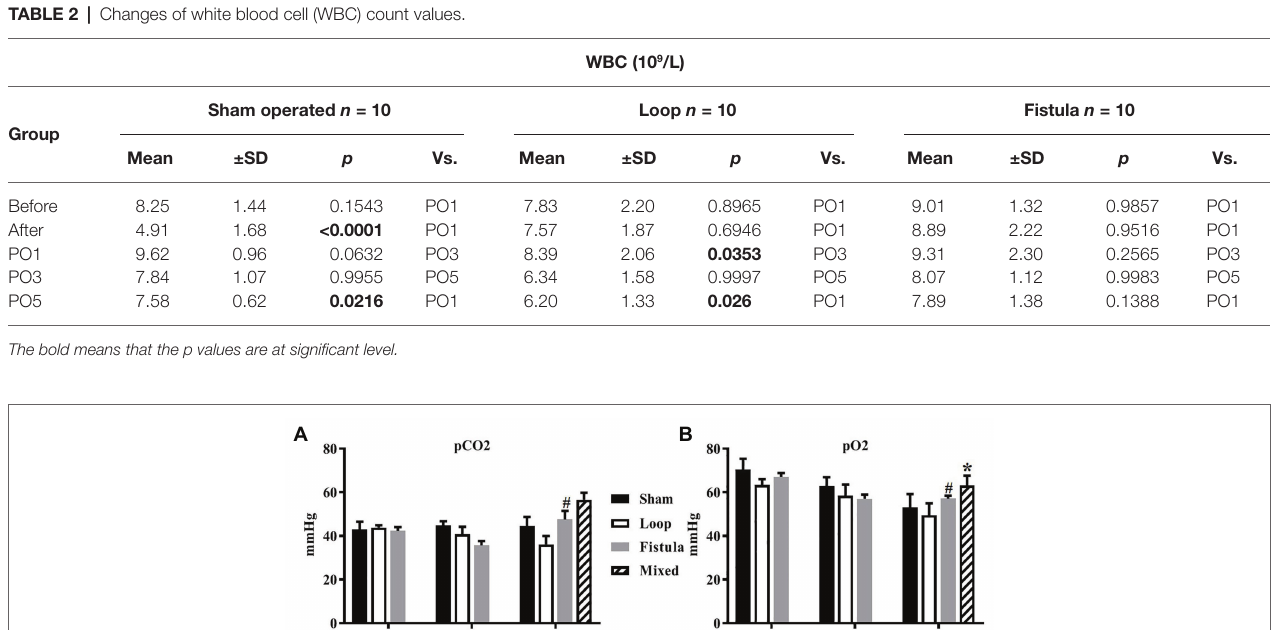
FIGURE 3 | Changes of partial carbon dioxide pressure (A) and partial oxygen pressure (B) . n = 10, mean ± SEM, * p < 0.05 vs. fistula at the PO5 week, # p < 0.05 vs. fistula before operation.